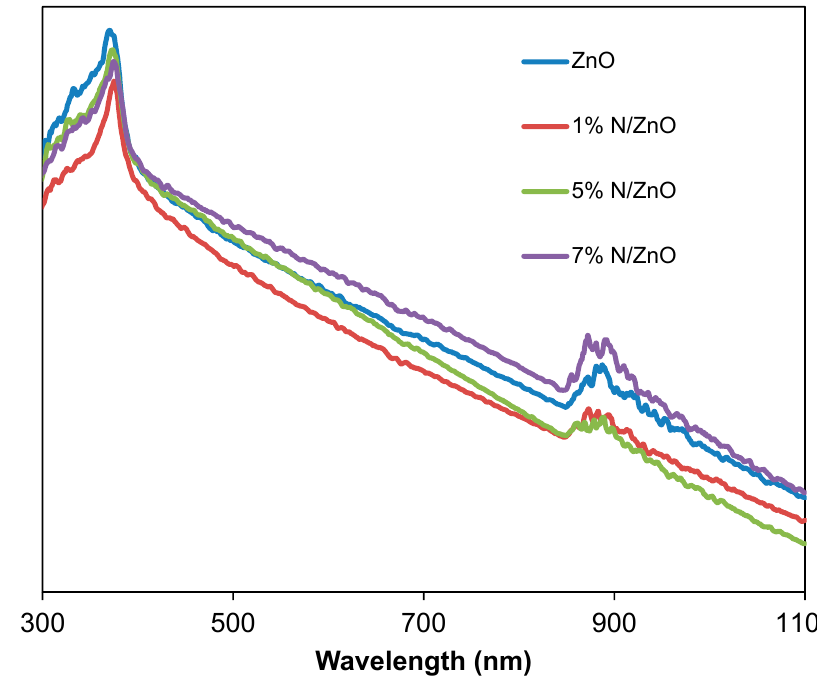
Figure 5. UV − Vis − NIR spectra of undoped and N-doped ZnO nanocomposites.